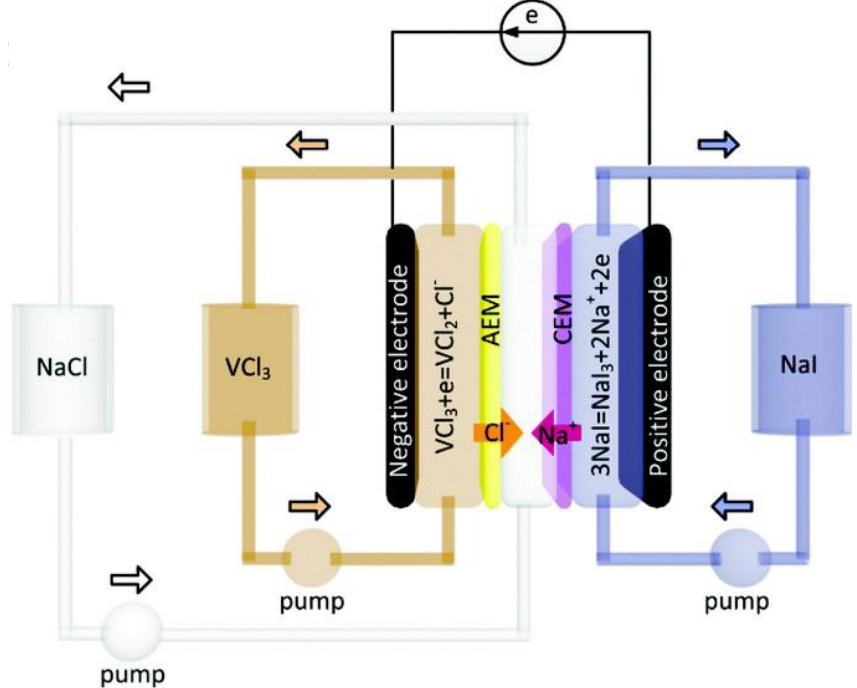
Figure 5. A typical redox flow desalination cell. Reproduced with permission from [99]. Copyright 2018 Royal Society of Chemistry.